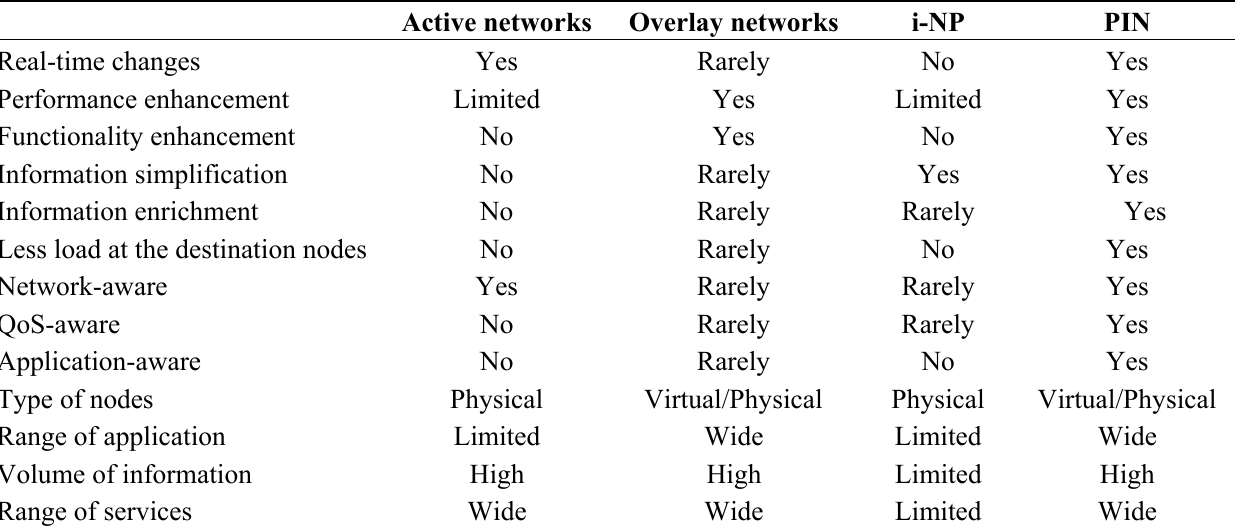
Table 2. Comparison of PIN with previous